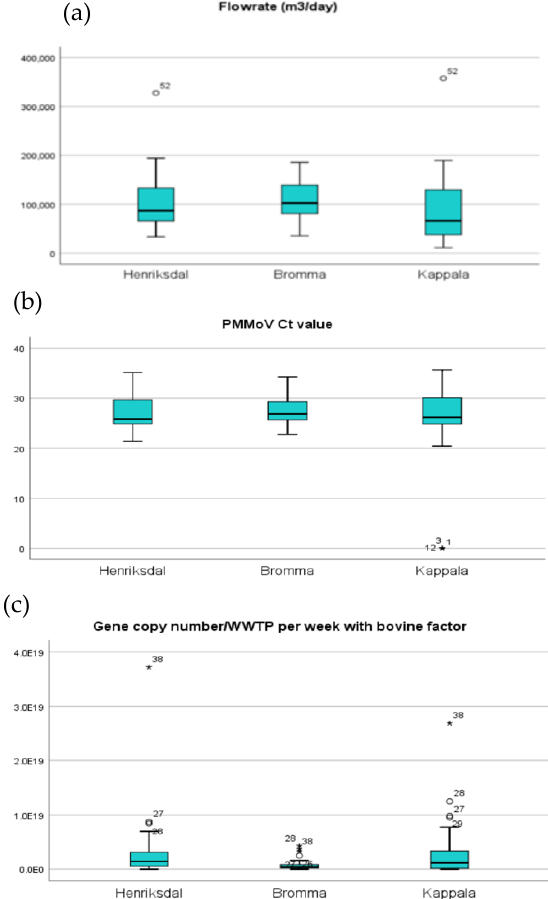
Figure 2. Distribution of the parameters for the individual regions in Stockholm during the study period. ( a ) Flowrate (m 3 /day). ( b ) PMMoV levels (Ct value). ( c ) SARS-CoV-2 levels (N-gene copy number per week per WWTP, adjusted by the bovine factor).